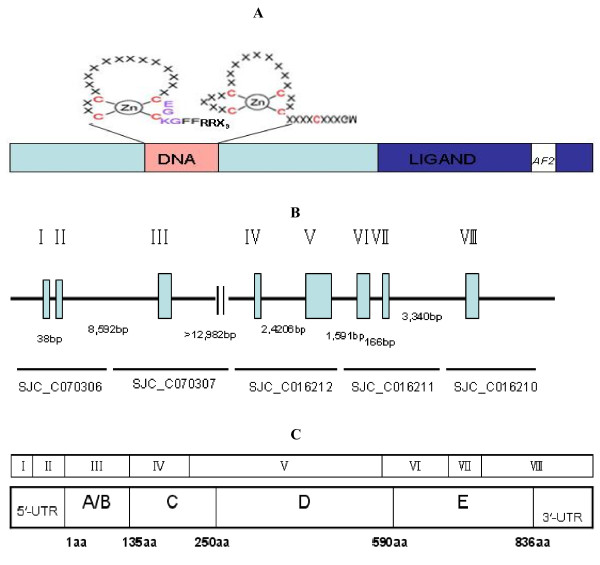
Gene structure of SjTHRβ.A Two zinc-finger modules of DNA Binding Domain in SjTHRβ B Exons (roman numerals) and introns are shown with bp sizes indicated. The five genomic supercontigs obtained from the SDSPB genomic sequence database (SJC_C070306, SJC_C070307, SJC_C016210, SJC_C016211 and SJC_C016212) are shown in the figure. Roman numerals indicate exons. C The amino acid size of exons and their corresponding NR domains are shown. A/B, A/B domain; C, DNA binding domain; D, hinge domain; E, ligand binding domain.